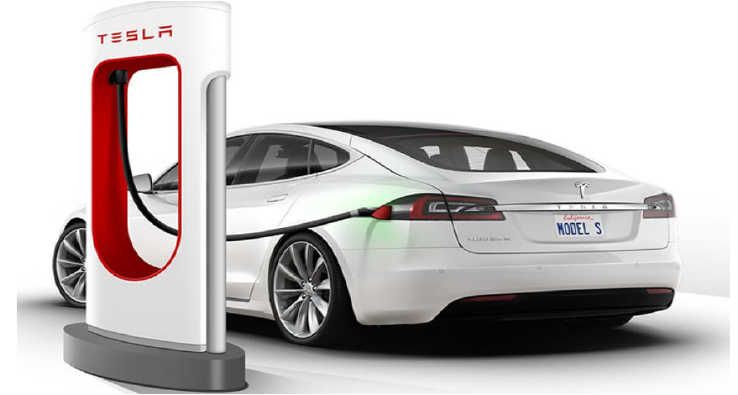
Figure 1. Photo of Tesla Model S (available online).